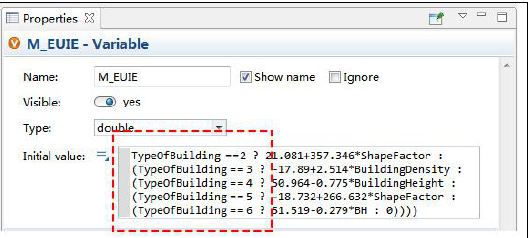
Figure 6. Personal characteristic parameter assignment command.